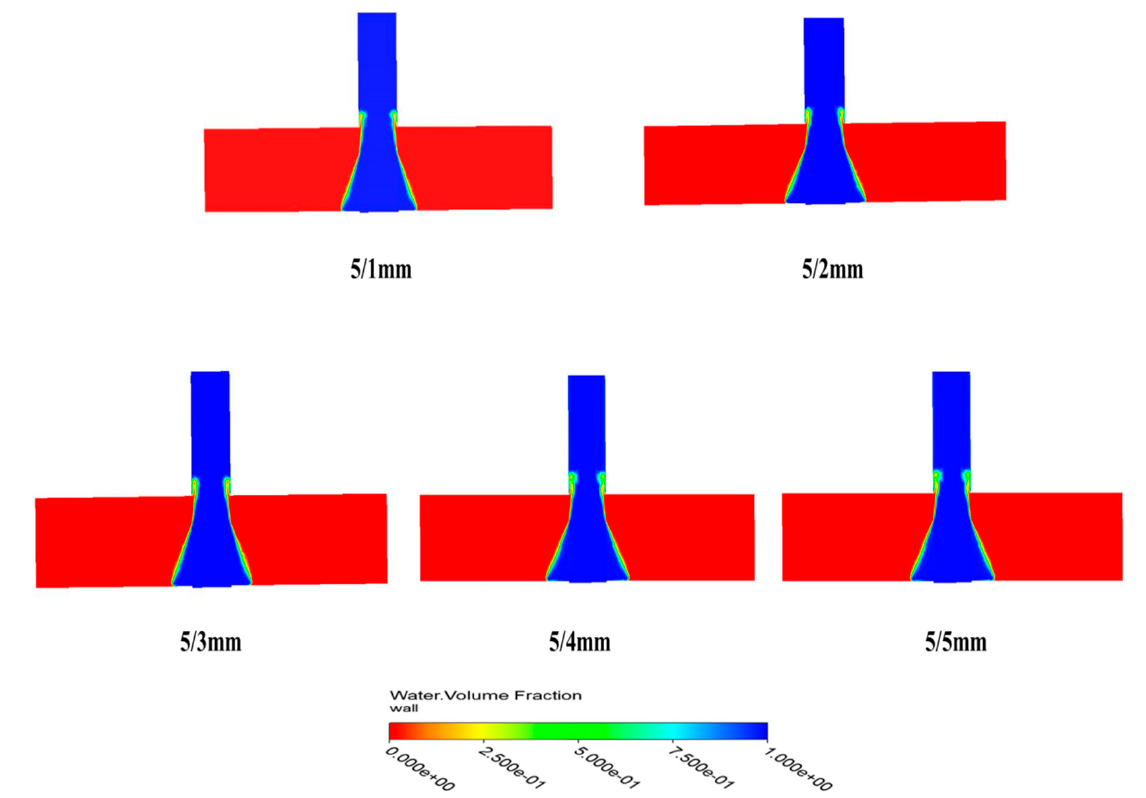
Figure 13. Volume fraction distribution of gas–liquid two-phase flow with different fracture widths at 0.4 s.